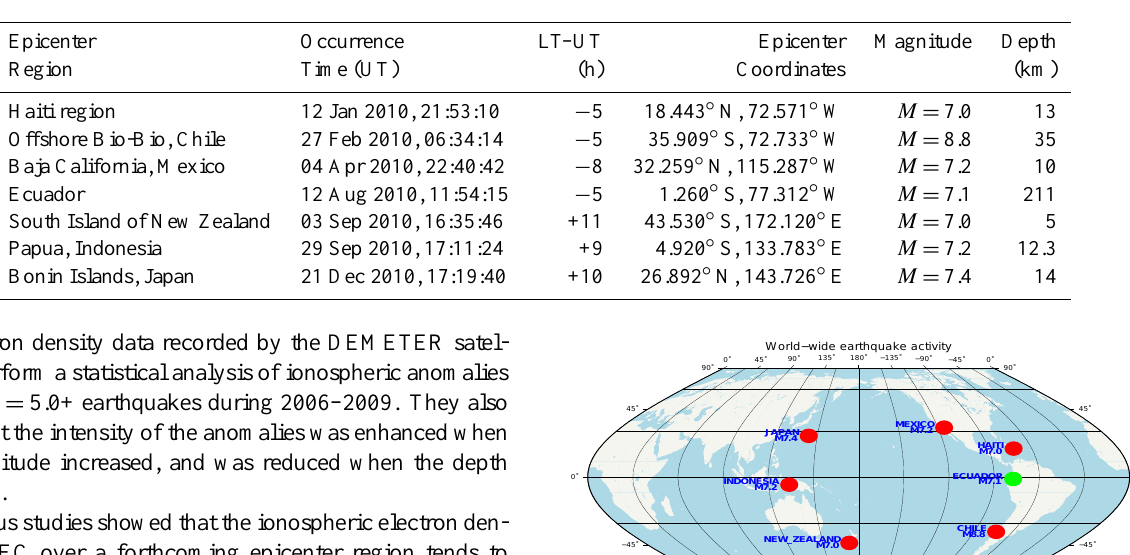
Table 1. Information on the seven selected earthquakes (http://earthquake.usgs.gov).